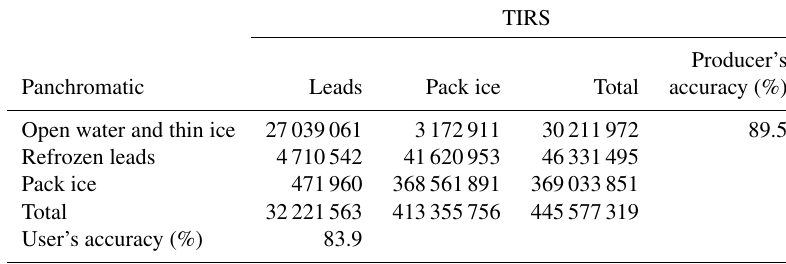
Table A1. Leads and pack ice pixels detected by Landsat-8 TIRS and panchromatic images at 15m